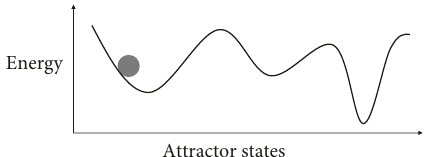
Figure 1: An attractor landscape, consisting of coexisting attractor states. Each attractor state is represented by a valley that provides a unique set of constraints on the movements of the ball. These movements represent the variability of lower-order components of the system. From De Ruiter et al.